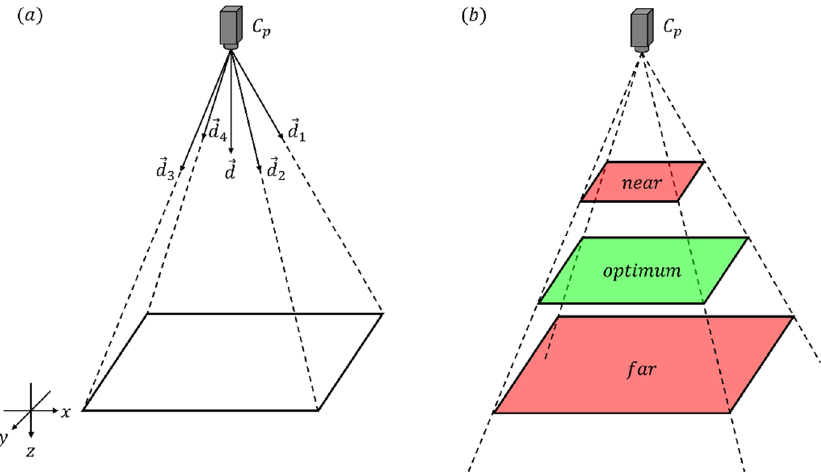
Figure 2. Visualization of the camera parameters for: ( a ) field of view, ( b ) focus.